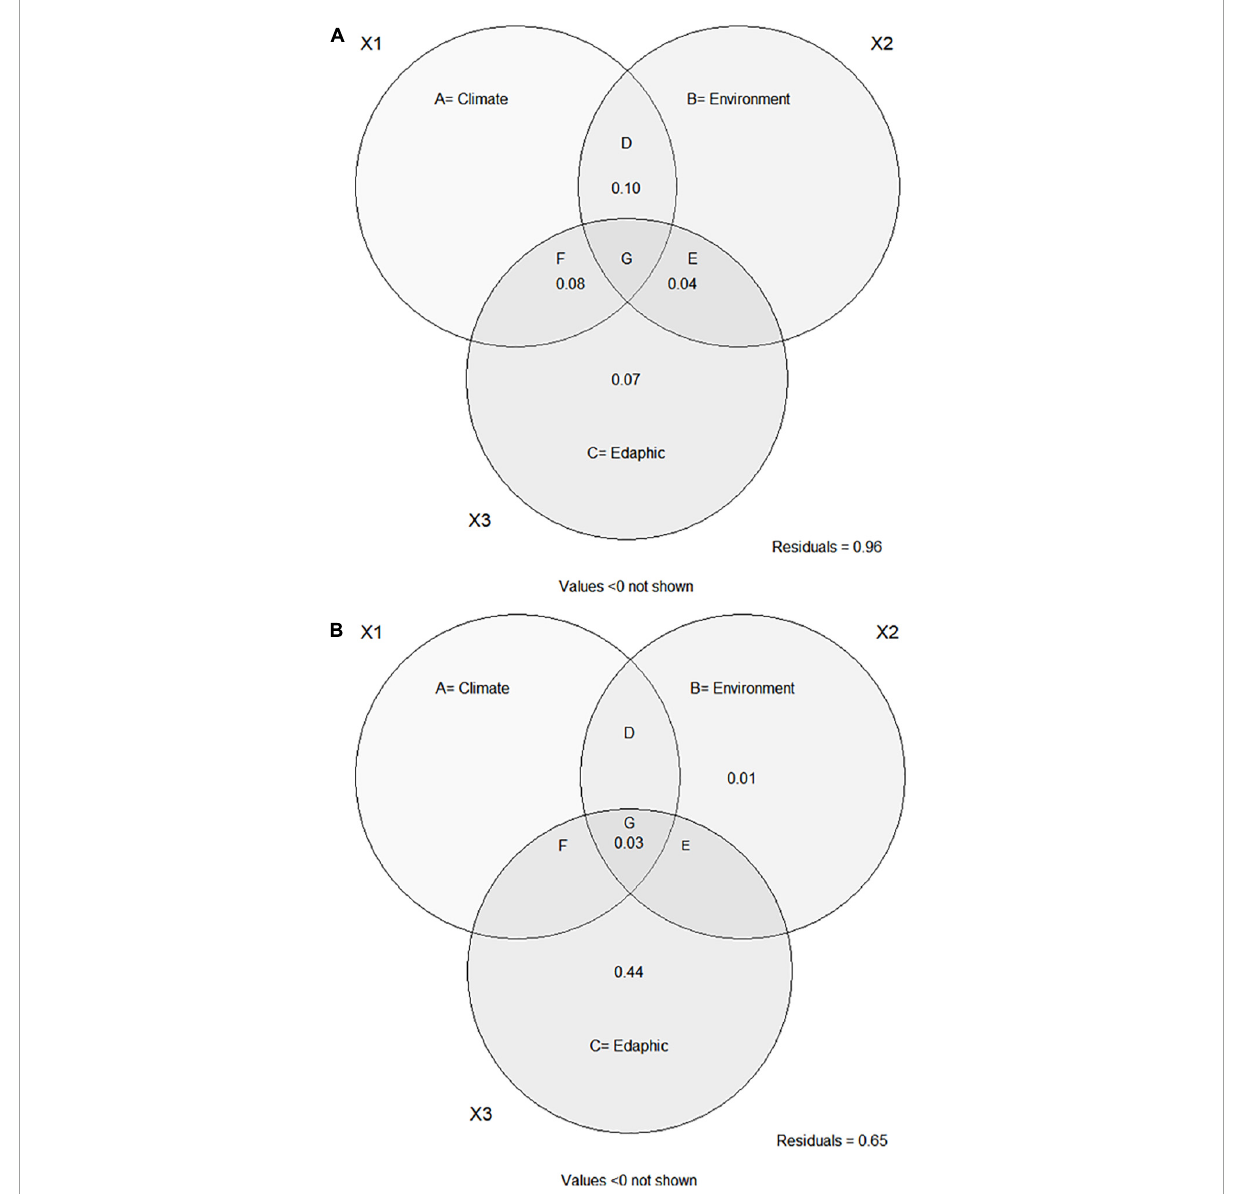
FIGURE4 Variance partitioning between the different components to explain the variation in soil PyC in forests in the Amazon-Cerrado transition. (A) With Amazon Dark Earth forests and (B) without these forests. Pure fractions: A = Climate (precipitation + MCWD + evapotranspiration in the driest month), B = Environment. (biomass + distance) and C = Edaphic (clay + silt); Shared fractions = D, E, F, and G; Values = 0 were not shown. Pearson’s correlation table (collinearity) can be found in the Supplementary Table 3